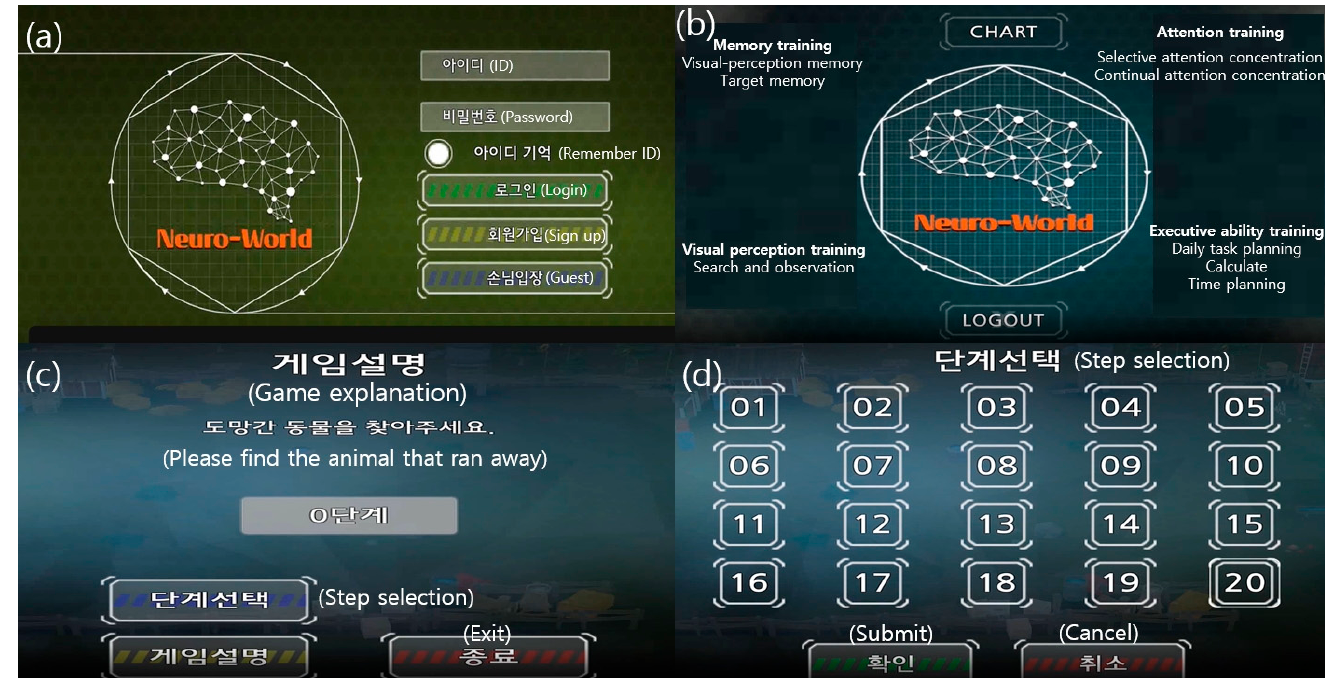
Figure 1. Initial progression page of the Neuro-World cognitive training program. ( a ) Login page, ( b ) main page of game, ( c ) page for selecting level of each game and game description page, ( d ) page for selecting level for games.